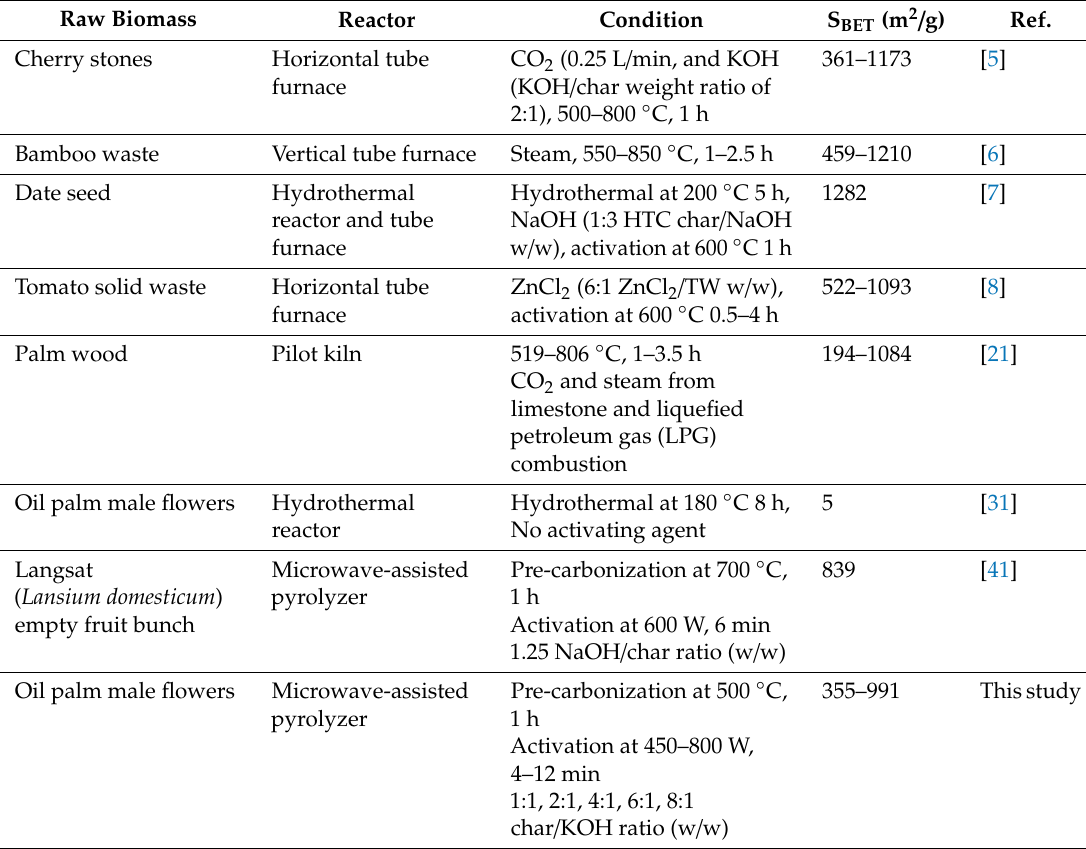
Table 4. Amount of production of nanoporous carbons from di ff erent manufacturing processes and di ff erent conditions. HTC, hydrothermal